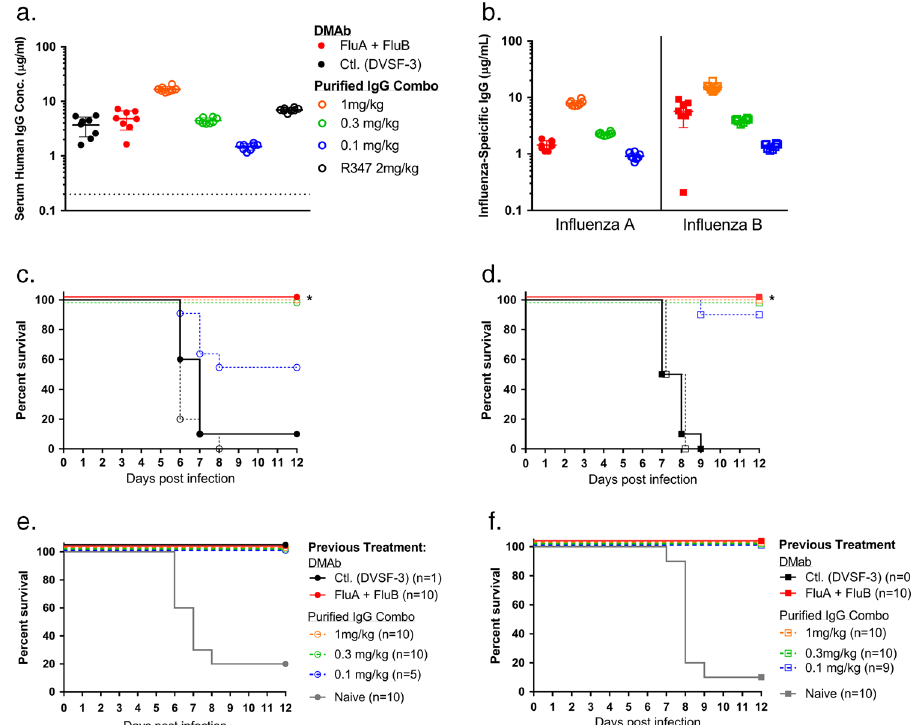
Fig. 5 Co-administration of FluA and FluB DMAb protects mice from lethal in fl uenza A/B challenge and homologous re-challenge. BALB/c mice received both FluA and FluB DMAb. Separate mice were treated with both FluA plus FluB protein monoclonal antibody. Mice received initial infection with either in fl uenza A/California/7/2009 or B/Florida/4/2006. a Total human IgG levels in mice sera at the time of infection ( n = 8 animals per group, mean ± SD). b In fl uenza A-speci fi c and B-speci fi c human IgG in mouse serum at the time of infection quanti fi ed by HA binding ELISA ( n = 8 animals per group, mean ± SD). c , d Kaplan – Meier survival curves following initial infection with A/California/07/2009 ( c ) or B/Florida/4/2006 ( d ) ( n = 10 animals per group, * p ≤ 0.0001 Flu DMAb versus control DMAb). e , f 28 days following initial infection, surviving mice received homologous in fl uenza re-infection. Kaplan – Meier survival curves following re-infection, compared to mice receiving neither DMAb/IgG treatment nor initial infection (naïve). (Number of animals in each group are